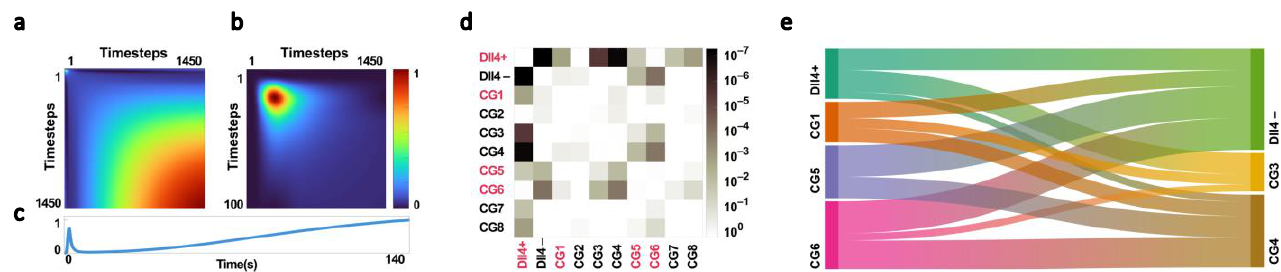
Figure 5. ( a , b ) The covariance parameter of a mixed-effects model for 1400 timesteps with appropriate time-varying covariates, used to analyze the average fluorescence intensity of ICG in the tumor with multiple measurements per subject, with the subject number serving as the repeated measure indicator and the rat strain serving as a covariate. ( c ) Projection of the diagonal of the covariance parameter on the time axis. ( d ) Multiplicity-adjusted p -value matrix showing significant differences between groups based on multiple comparison of estimated marginal means using the Tukey–Kramer test statistic. ( e ) Sankey diagram showing differences in strains with high and low levels of Dll4 expression based on the A score (mean of accuracy, sensitivity, and specificity in the primary classification of each pair); 0.65 was subtracted from all the A score values for better visualizations of differences.